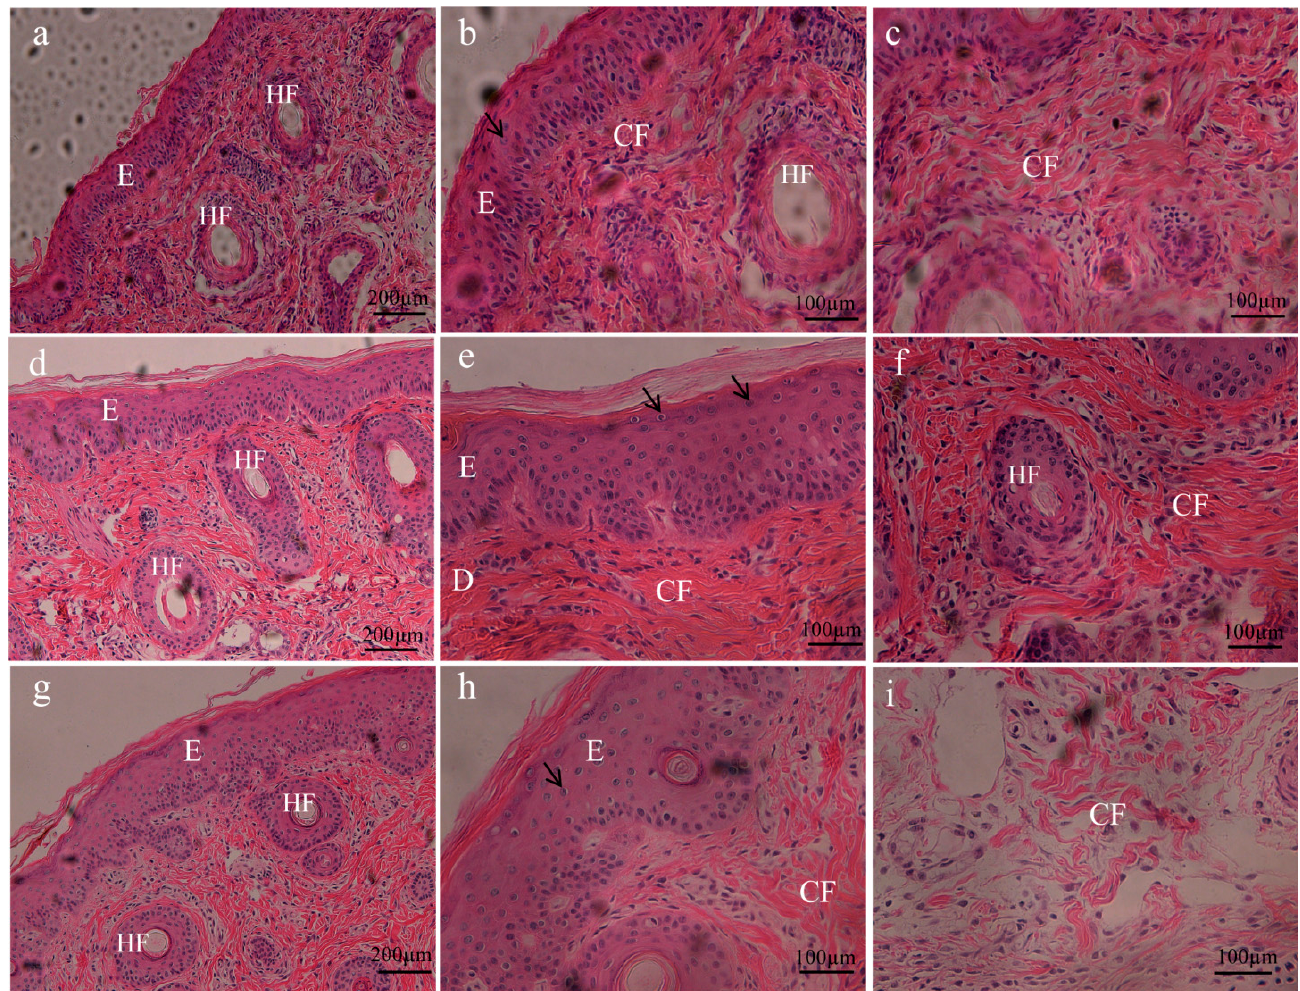
Figure 4. The histological analysis of ear tissues cryopreserved for 6 months. HE staining in representative pig ear sections obtained from fresh tissue, cryopreserved tissue and the tissue frozen without protection. ( a – c ): fresh tissues; ( d – f ): cryopreserved tissues; ( g – i ): tissue frozen without protection.